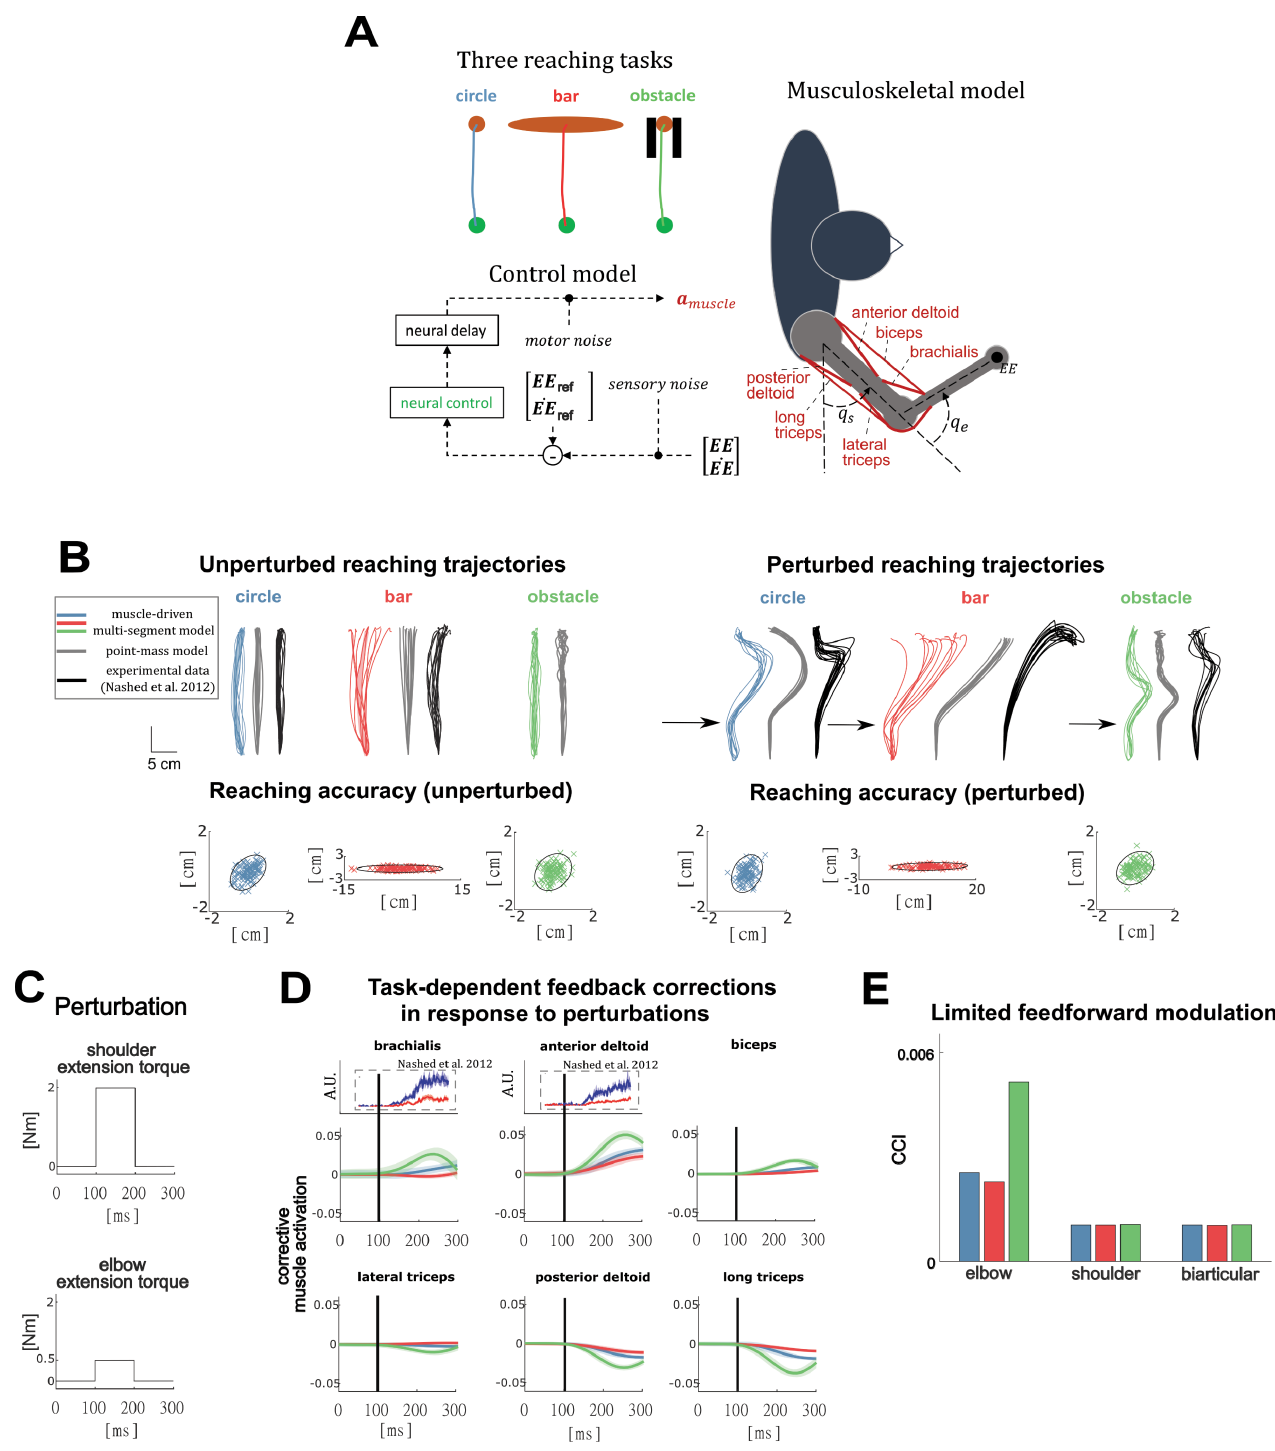
Fig 2. A: Schematic representation of the three reaching tasks and the musculoskeletal and control model. We simulated three different reaching tasks: (1) reaching towards a small circular target (blue), (2) reaching towards a horizontal bar (red), and (3) reaching towards a circular target in the presence of an obstacle (green). In all simulations, muscle excitations consist of feedforward and feedback contributions. The feedback controller is driven by the error ; _ EE ) and is corrupted by sensory noise. Muscle forces are between the end-effector kinematics ( EE ; _ EE ) and the nominal end-effector kinematics ( EE ref ref dependent on muscle activations ( a ), which are time-delayed muscle excitations, and resulting joint torques are corrupted by motor noise. B: Unperturbed muscle